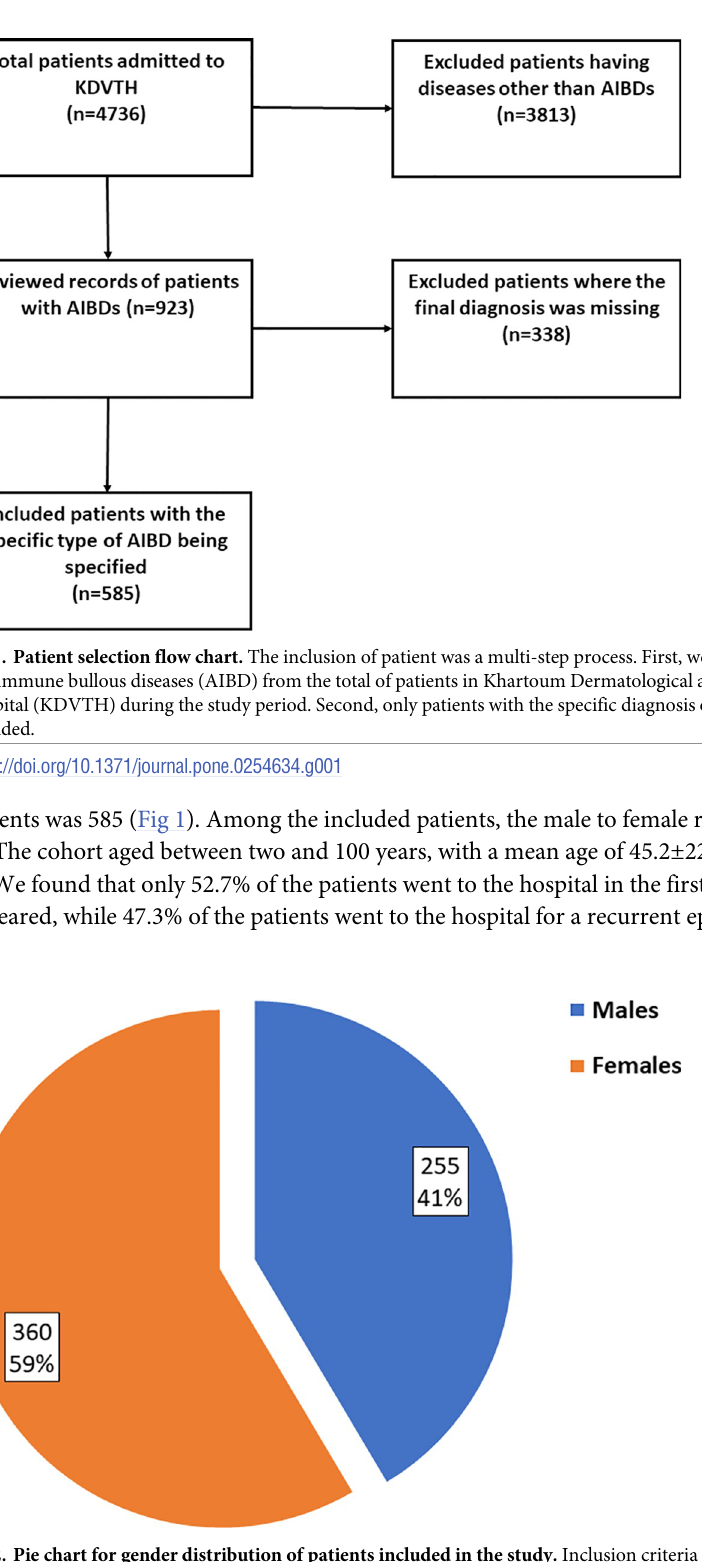
PLOS ONE | https://doi.org/10.1371/journal.pone.0254634 July 13,